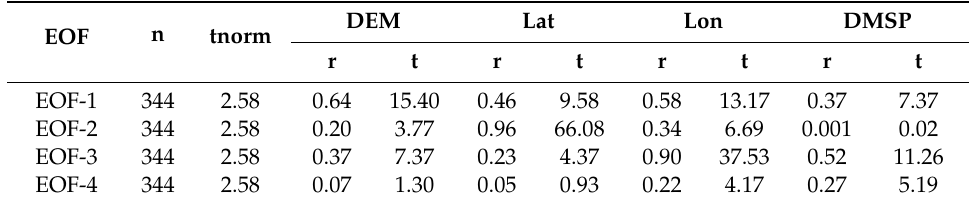
Table 2. Pearson correlation coe ffi cient between precipitation spatial distribution of EOF and the main